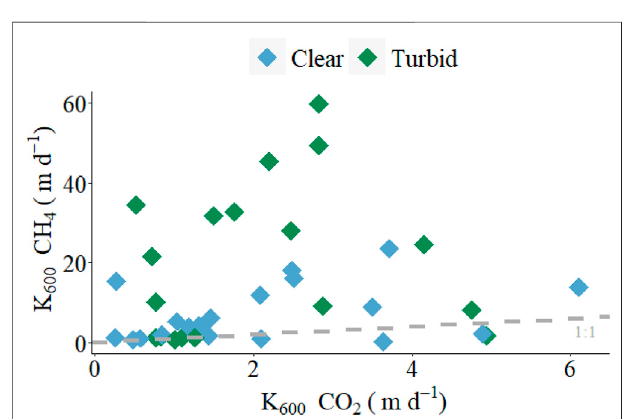
FIGURE3| Linearregressionbetween k 600 CH 4 (md − 1 )and k 600 CO 2 (m d − 1 ). The dashed line represents the expected 1:1 relation between standardized exchange velocities. Blue diamonds correspond to clear vegetated lakes and green diamonds correspond to turbid algal